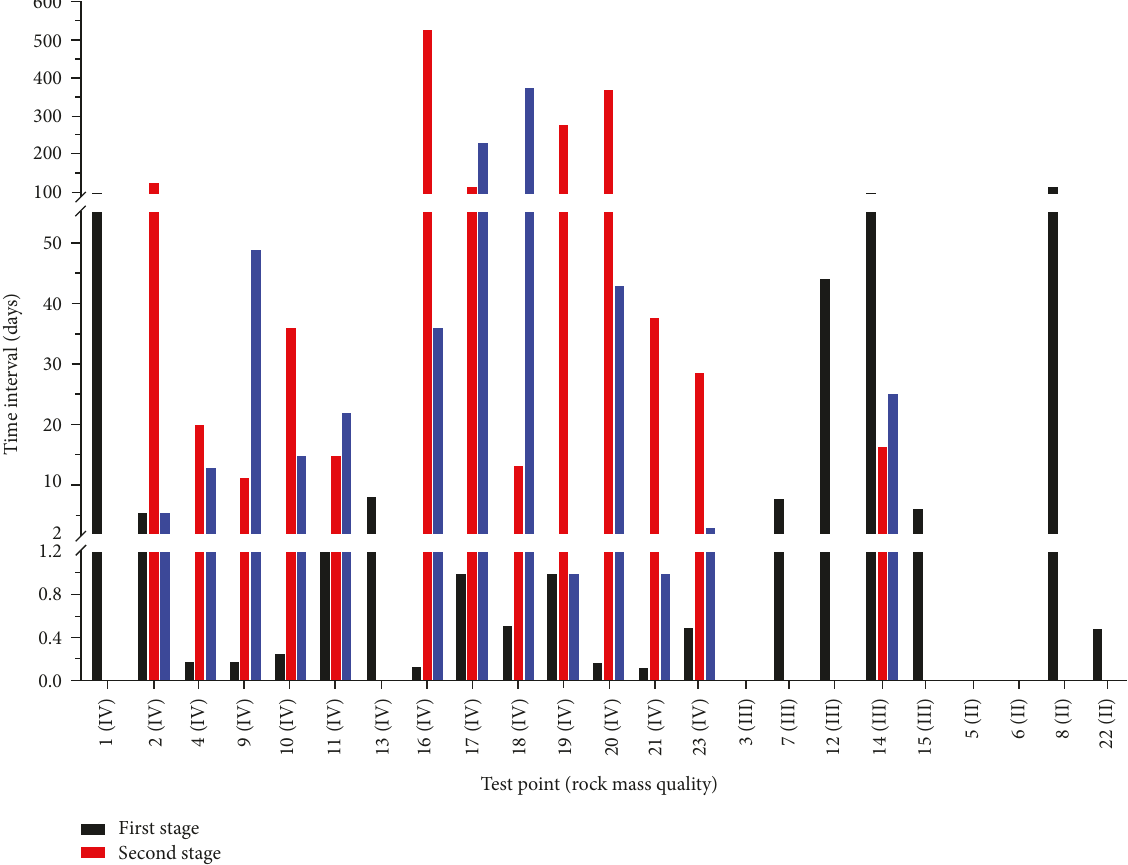
Figure 13: Time interval between each supporting measure at each test point